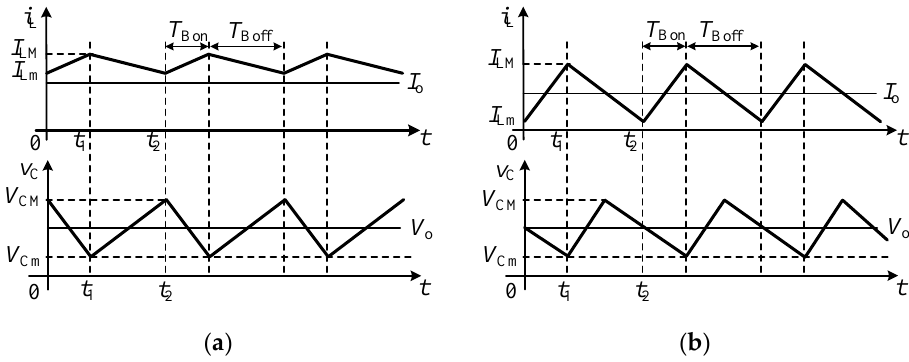
Figure 14. The inductor current and capacitor voltage waveforms of a continuous conduction mode (CCM) boost circuit: ( a ) the waveform of the complete inductor power supply mode (CISM) and ( b ) the waveform of the incomplete inductor power supply mode (IISM).